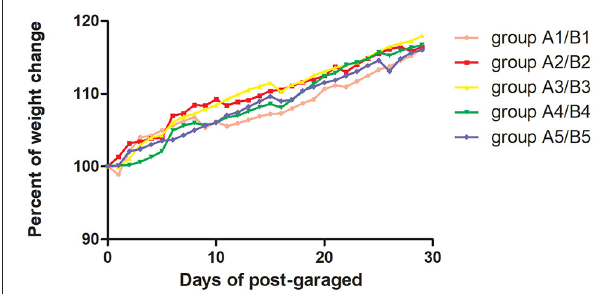
FIGURE 1 | The present of body weight change of mice was tested every day. The body weight was the average of 40 mice in one group. Pink curve was group A1/B1 with Sterilized saline by gavage, red curve was group A2/B2 with 2 × 10 6 CFU/mL by gavage; Blue curve was group A3/B3 with 2 × 10 7 CFU/mL by gavage, green curve was group A4/B4 with 2 × 10 8 CFU/mL by gavage, and deeply purple curve was group A5/B5 with 2 × 10 9 CFU/mL by